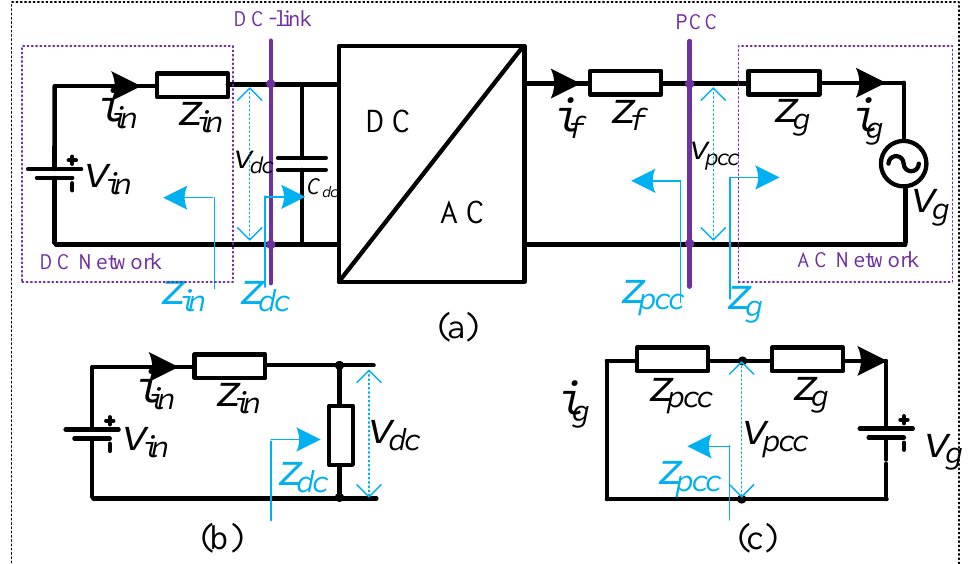
Figure 1. Block diagram of ( a ) a typical DC to AC interface for connecting an AC network and DC network from a small signal impedance perspective, ( b , c ) An equivalent representation of the entire system seen from the DC side and the AC side,